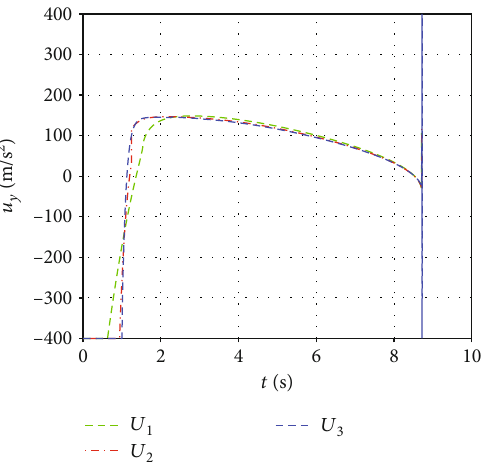
Figure 37: Acceleration instruction u